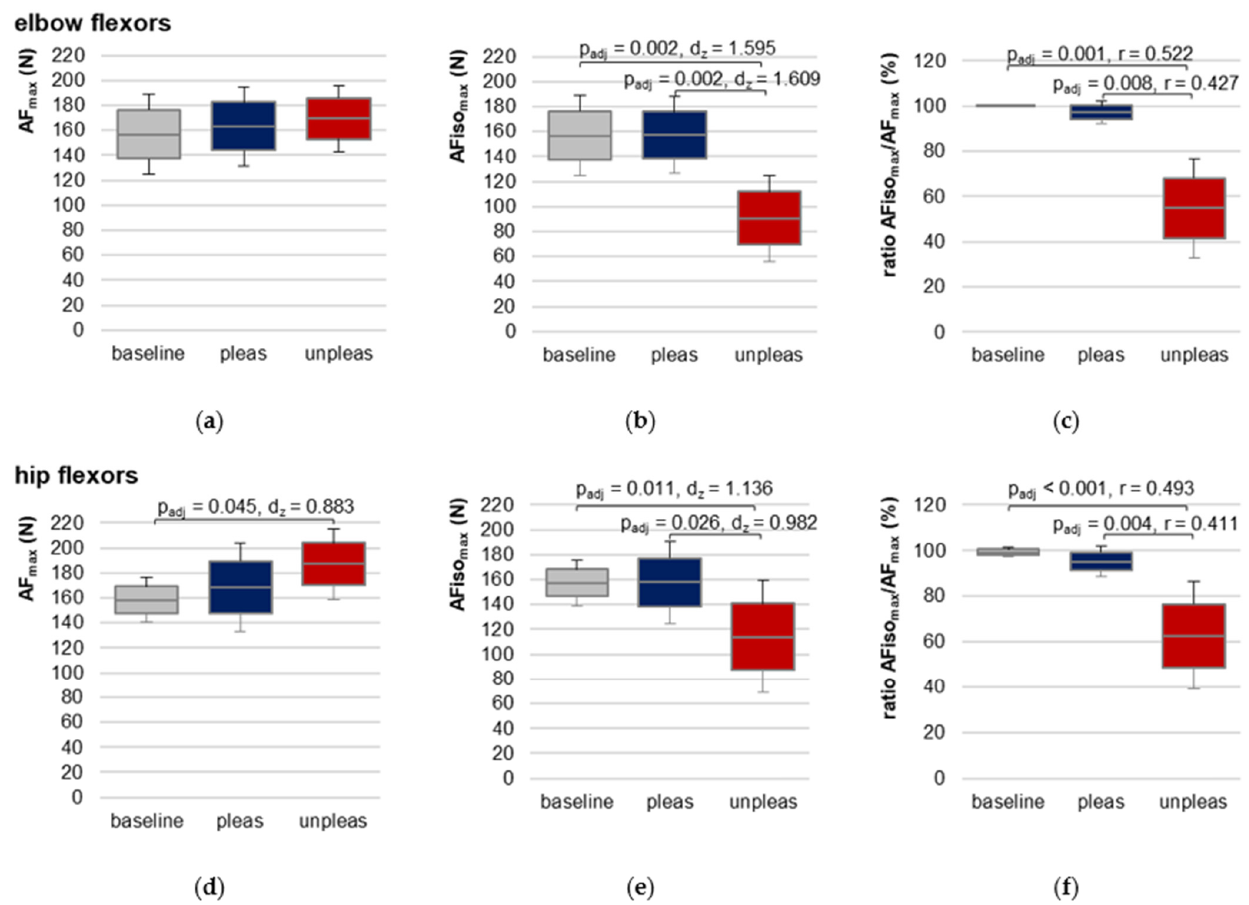
Figure 5. Maximal Adaptive Force and maximal isometric Adaptive Force. Arithmetic means, standard deviations (error bars) and 95% CIs of the maximal Adaptive Force (AF max ; ( a , d )), the maximal isometric Adaptive Force (AFiso max ; ( b , e )) and their ratio ( c , f ) compared between baseline (grey), pleasant (pleas, blue) and unpleasant (unpleas, red) imagery for elbow ( a – c ) and hip flexors ( d – f ) are displayed. Adjusted p values (Bonferroni correction) and effect sizes (Cohen’s d z or Pearson’s r ) are given in case of significance.